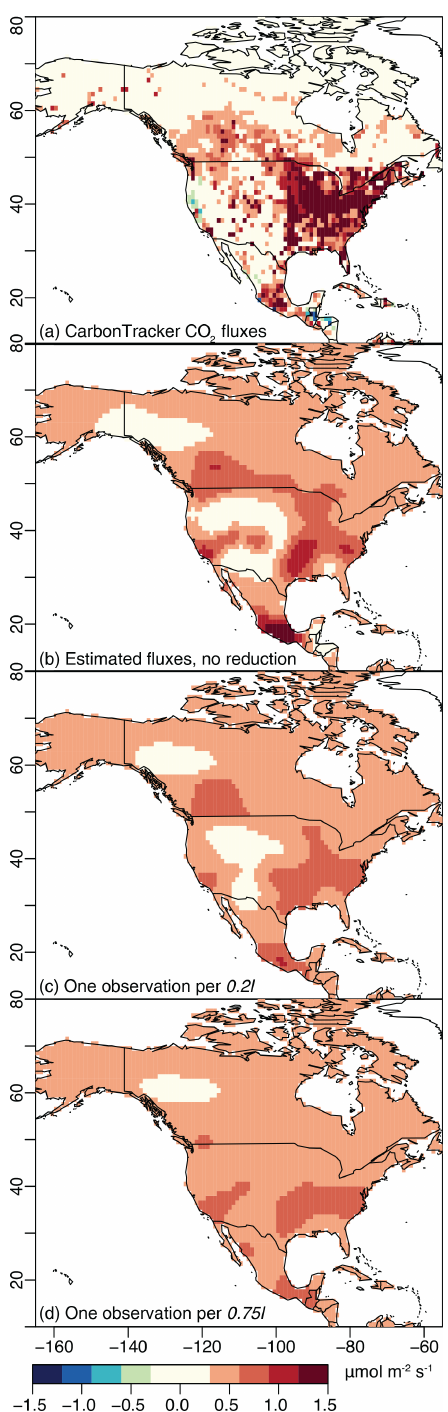
Figure 4. CO 2 fluxes estimated for the winter case study, analo- gous to Fig. 3. The fluxes estimated with modest data reduction ( c ; 1098 data points) reproduce the patterns in the flux estimate with no reduction ( b ; 4183 data points). By contrast, large data reduction ( d ; 251 data points) yields fluxes with little spatial